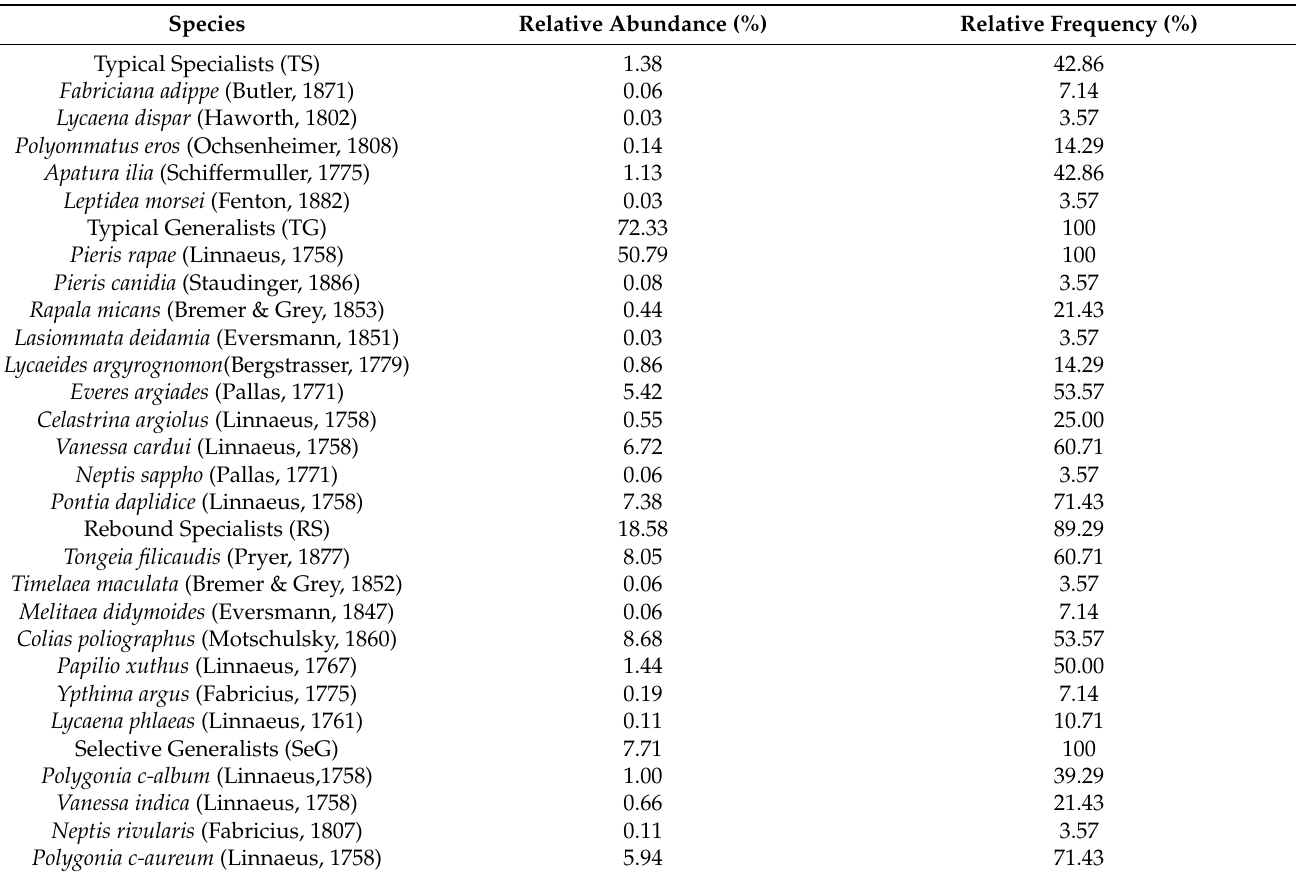
Table 3. The relative species abundance and frequency of the four butterfly groups. The relative species abundance relates to the proportion of the number of individuals of each species relative to the total number of butterflies. The relative frequency relates to the proportion of parks where each butterfly species was distributed relative to the total number of parks. Species Relative Abundance (%) Relative Frequency (%) Typical Specialists (TS) 1.38